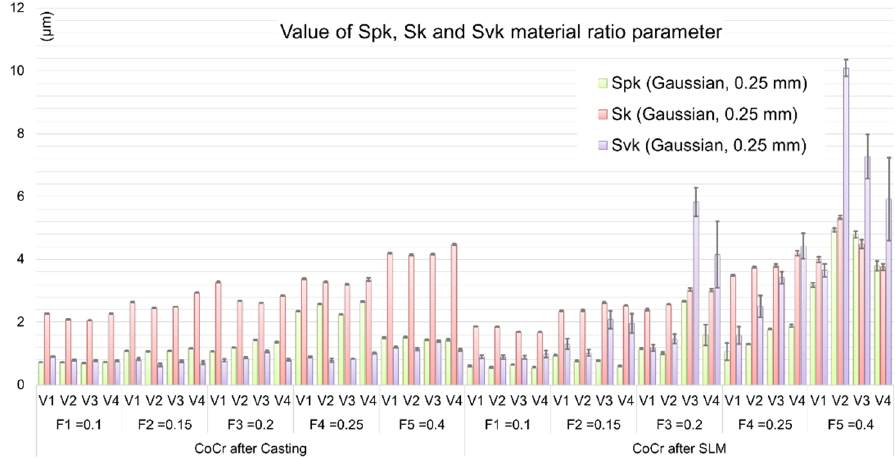
Figure 6. Comparison of material ratio curve parameters obtained for tested CoCr alloys and different f values.